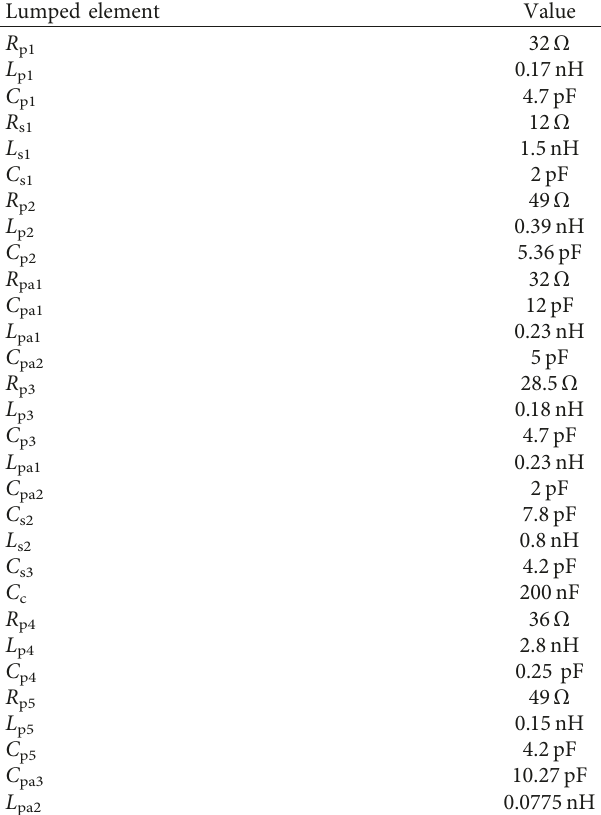
Table 3: The optimal component values of an equivalent circuit model of the proposed antenna. Lumped element